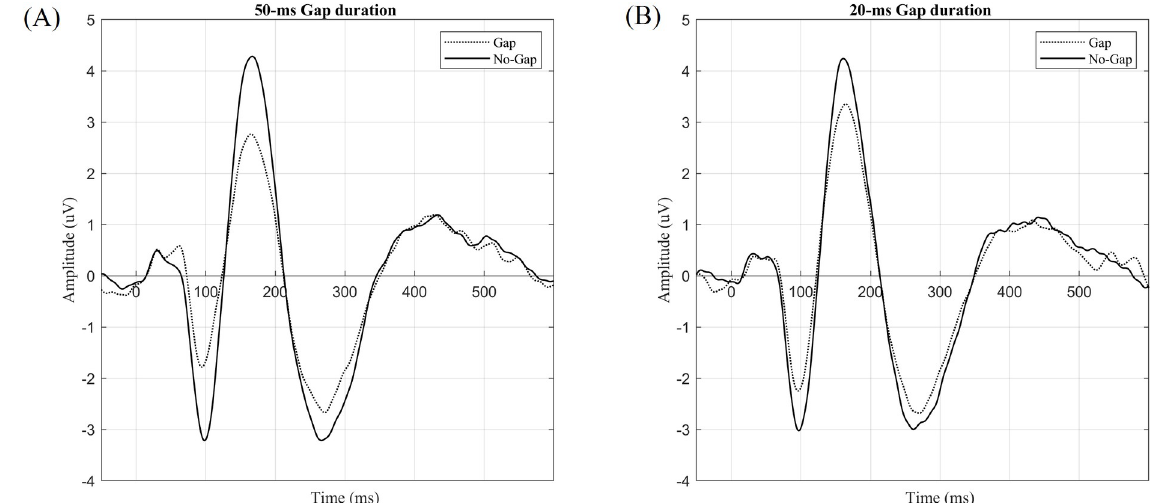
Fig 2. Grand averaging waveforms of the 50 (A) and 20 ms (B) gap durations. Stimulus initiation was set as time zero.